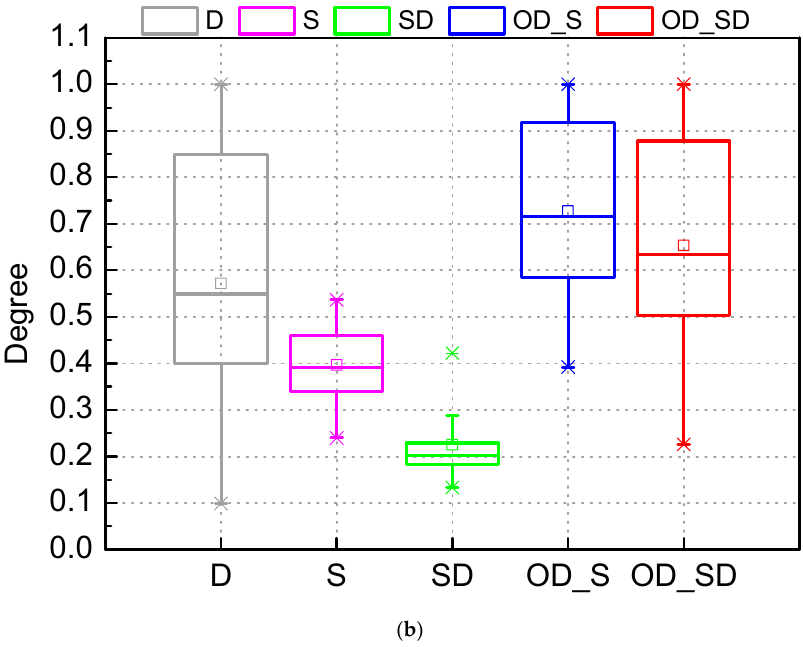
Figure 8. Alteration degree of the 32 hydrologic parameters by five assessment methods. Figure 8. ( a ) Alteration degrees by five measures (i.e., D , S , SD , OD _ S , and OD _ SD , including three single measures and two composite measures) for each hydrologic parameter, ( b ) Alteration degree of Table 3. Alteration degree of the 32 hydrologic parameters. the 32 hydrologic parameters by five assessment methods. Table 3. Alteration degree of the 32 hydrologic